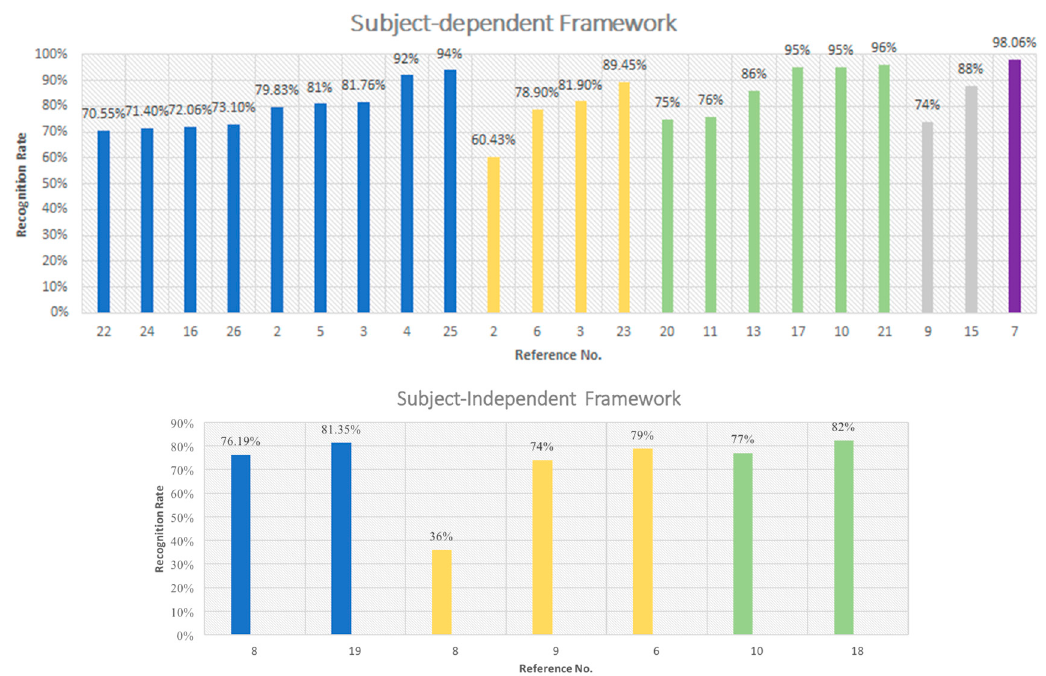
Figure 17. Subject-dependent and Subject-independent recognition rate. (The horizontal axis represents the same sequence number as the Table 3. Different colors represent different classification categories: Blue—two categories, yellow—three categories, green four—categories, grey—five categories, purple—six categories).